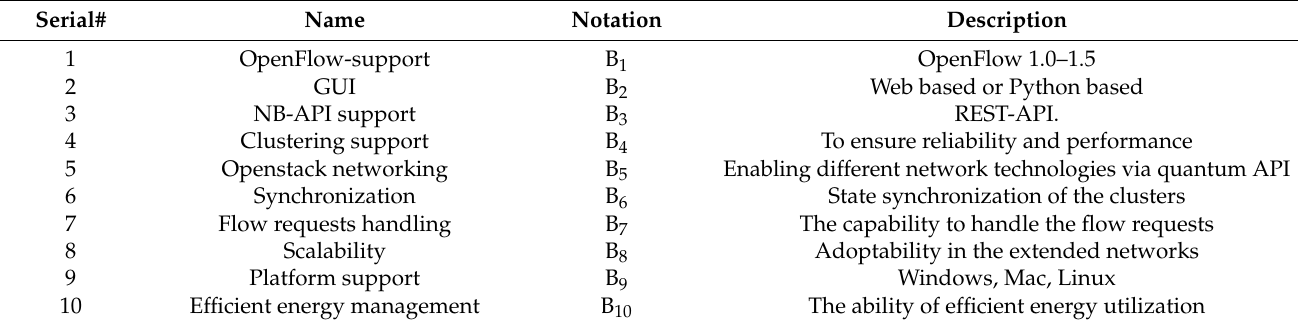
Table 1. List of features for SD-IoT performance evaluation.